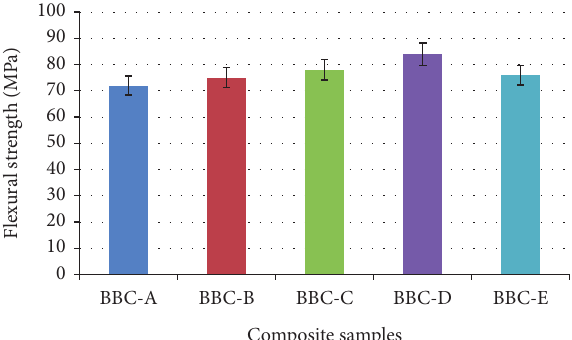
Figure 11: Flexural strength of composite samples.